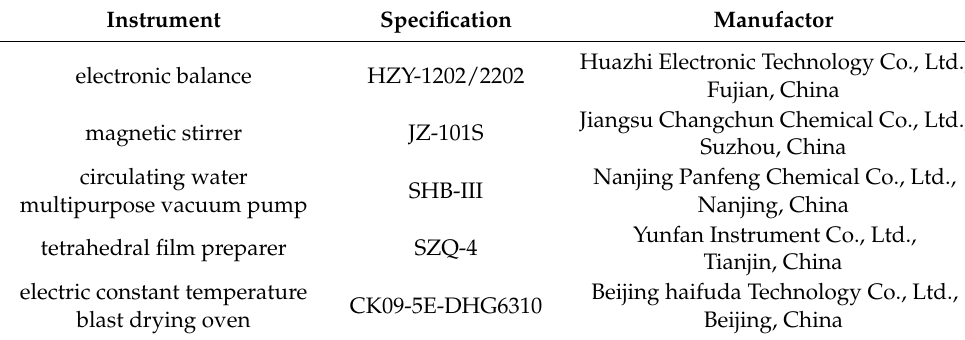
Table 2. List of equipment in